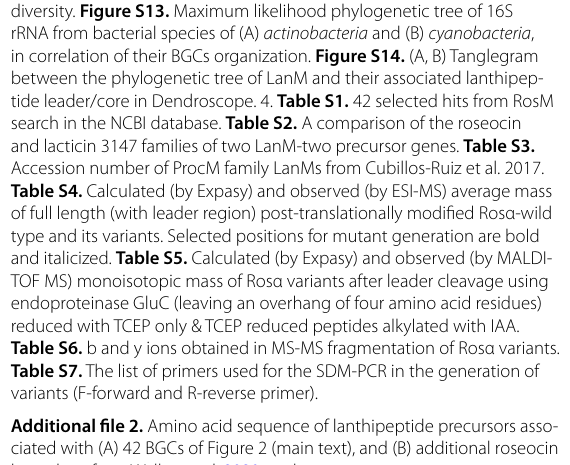
diversity. Figure S13. Maximum likelihood phylogenetic tree of 16S rRNA from bacterial species of (A) actinobacteria and (B) cyanobacteria , in correlation of their BGCs organization. Figure S14. (A, B) Tanglegram between the phylogenetic tree of LanM and their associated lanthipep- tide leader/core in Dendroscope. 4. Table S1. 42 selected hits from RosM search in the NCBI database. Table S2. A comparison of the roseocin and lacticin 3147 families of two LanM-two precursor genes. Table S3. Accession number of ProcM family LanMs from Cubillos-Ruiz et al. 2017. Table S4. Calculated (by Expasy) and observed (by ESI-MS) average mass of full length (with leader region) post-translationally modified Rosα-wild type and its variants. Selected positions for mutant generation are bold and italicized. Table S5. Calculated (by Expasy) and observed (by MALDI- TOF MS) monoisotopic mass of Rosα variants after leader cleavage using endoproteinase GluC (leaving an overhang of four amino acid residues) reduced with TCEP only & TCEP reduced peptides alkylated with IAA. Table S6. b and y ions obtained in MS-MS fragmentation of Rosα variants. Table S7. The list of primers used for the SDM-PCR in the generation of variants (F-forward and R-reverse primer). Additional file 2. Amino acid sequence of lanthipeptide precursors asso- ciated with (A) 42 BGCs of Figure 2 (main text), and (B) additional